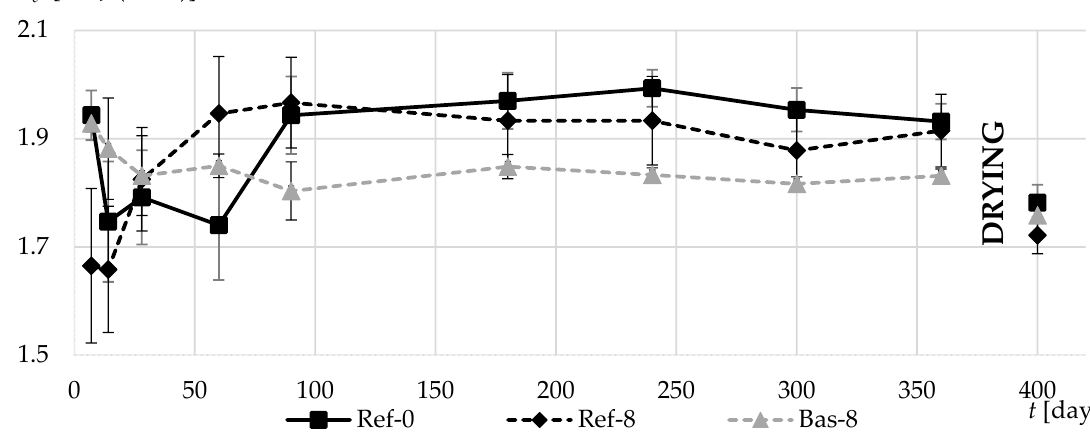
Figure 11. Volumetric specific heat coefficients in the first 360 days of composites curing and after additional drying.